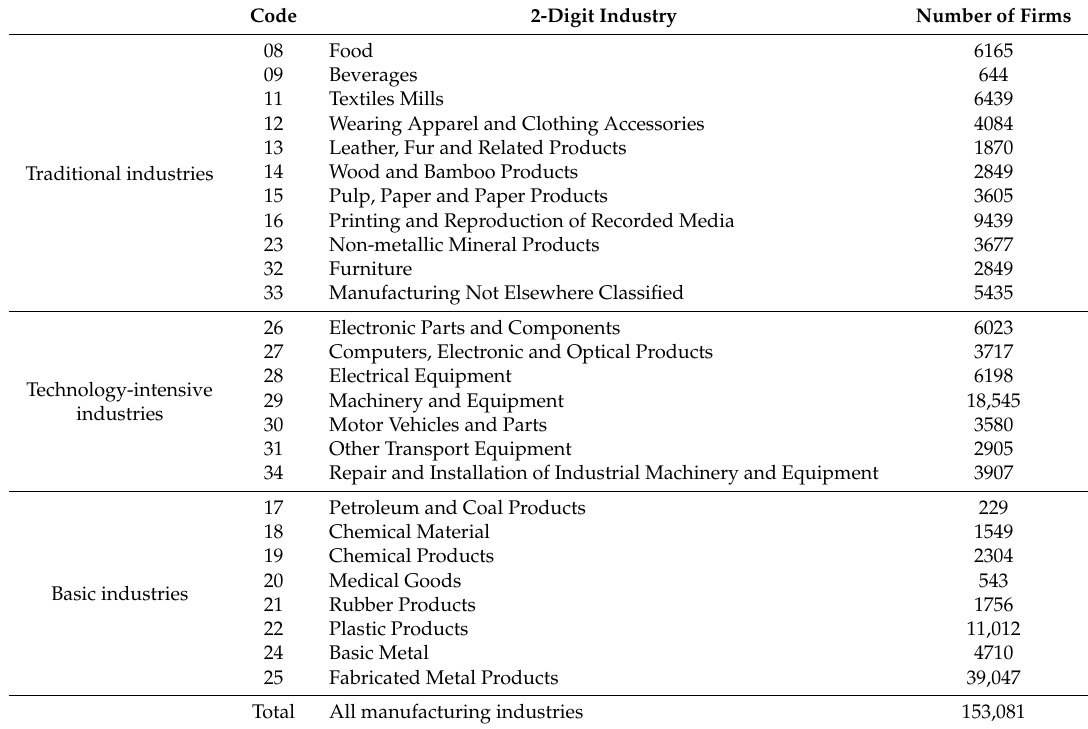
Table 1. Industry 2-digit codes and number of